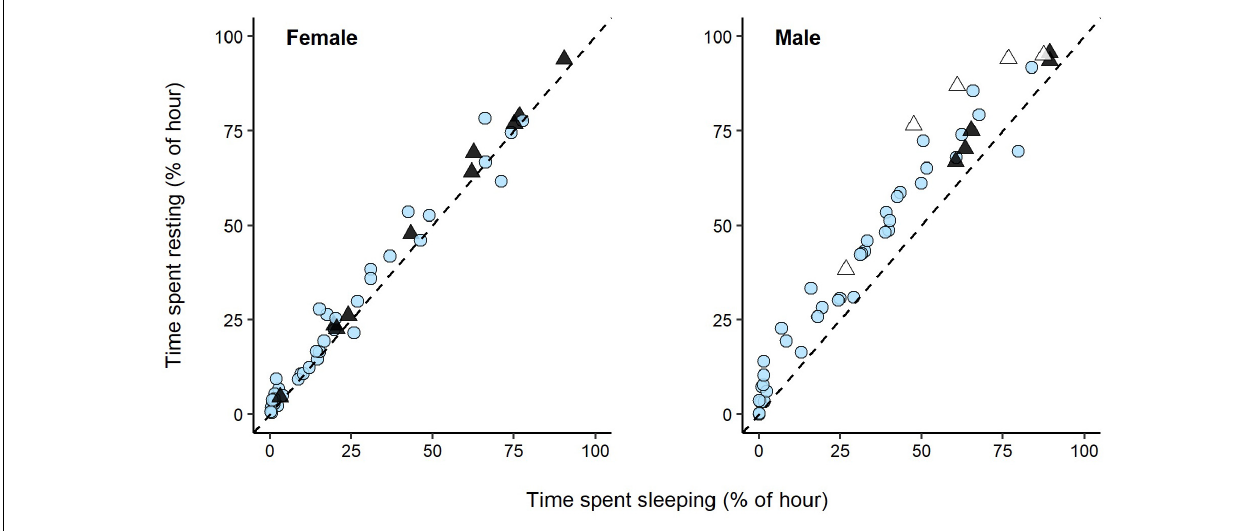
FIGURE 5 | Relationship between time spent sleeping and resting in an adult female and male swan. Sleep and rest were recorded for 48 h during daytime (blue circles), astronomical night with streetlights off (solid triangles), and astronomical night with white streetlights on (open triangles). The dashed line represents the situation where a time spent resting equals time spent